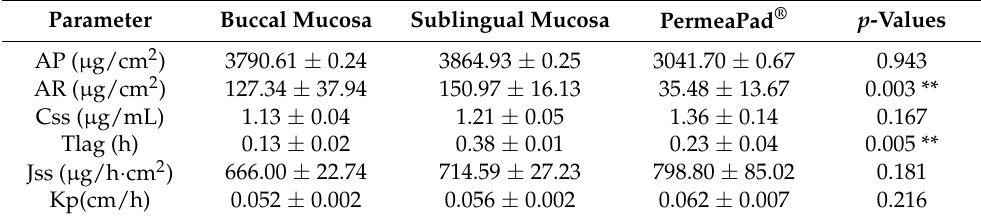
Table 2. Transmucosal biopharmaceutical permeation parameters of ketorolac 6 h after applying KT hydrogel under an infinite dose regimen according to first-order kinetics, and p -values from statistical analysis (one-way ANOVA). Results are expressed as Mean ± SD (n = 3).